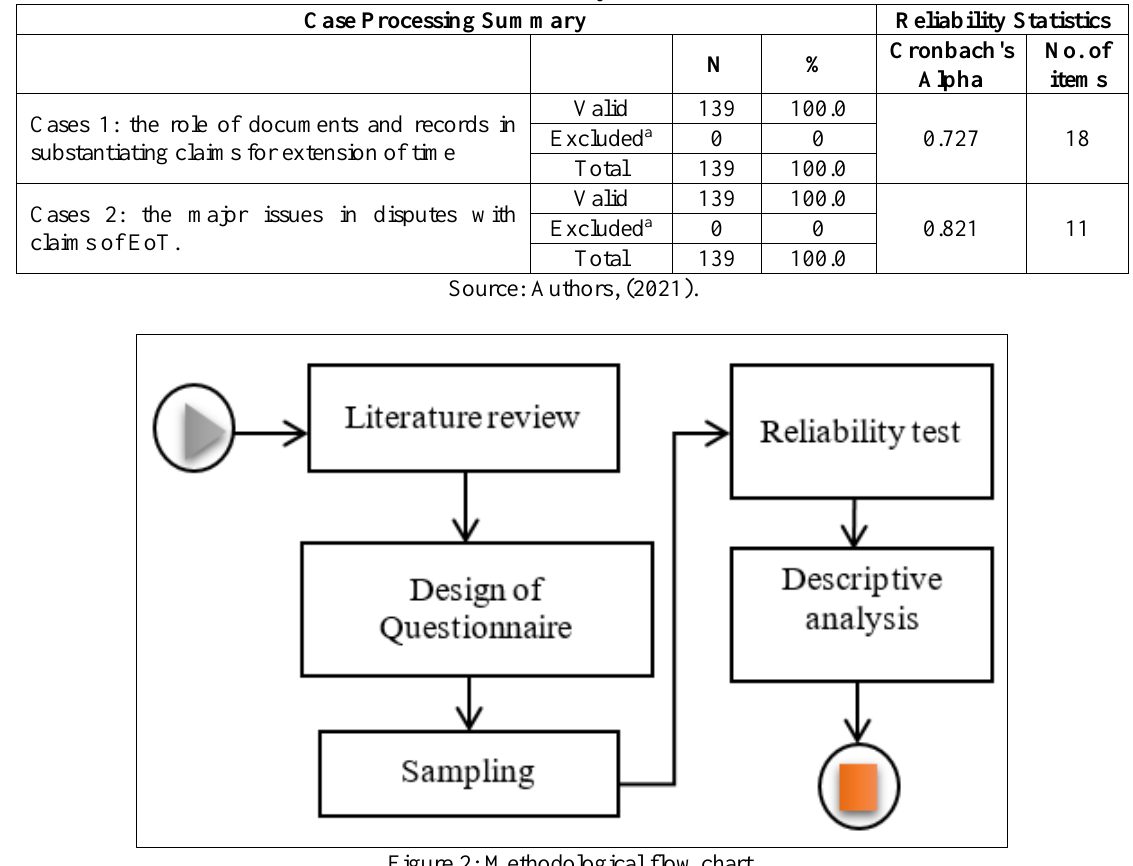
Table 3: Reliability Evaluation.